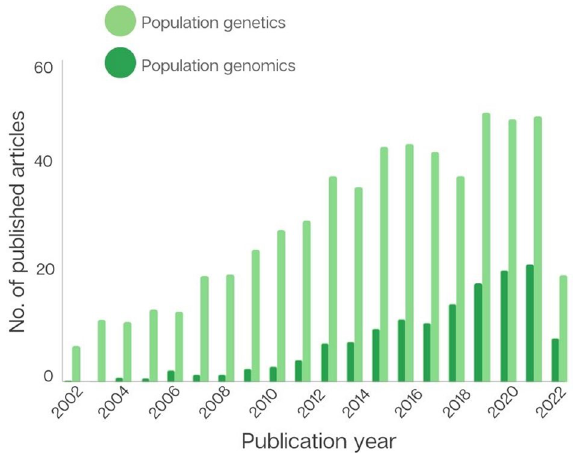
Figure 1. Number of published articles that apply “population genomics” (dark green) and “population genetics” (light green) in an invasive context over time (see Methods for details).